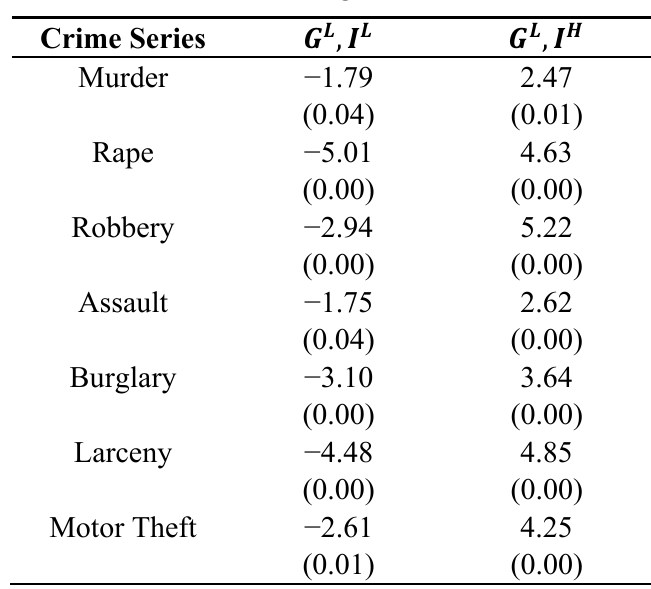
Table 2. Convergence in